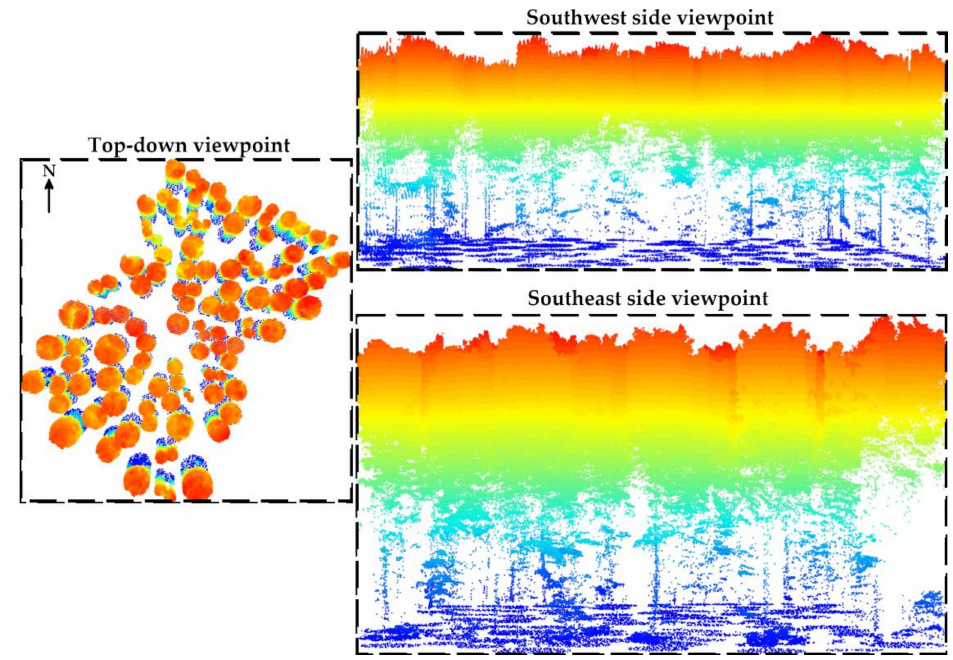
Figure 6. Individual trees detection and segmentation based on the field measures and using circular buffers. For each tree, the radius threshold was set to half the distance among its nearest neighbors. Note that each cross-section is at a different scale in order to increase the visibility of the study